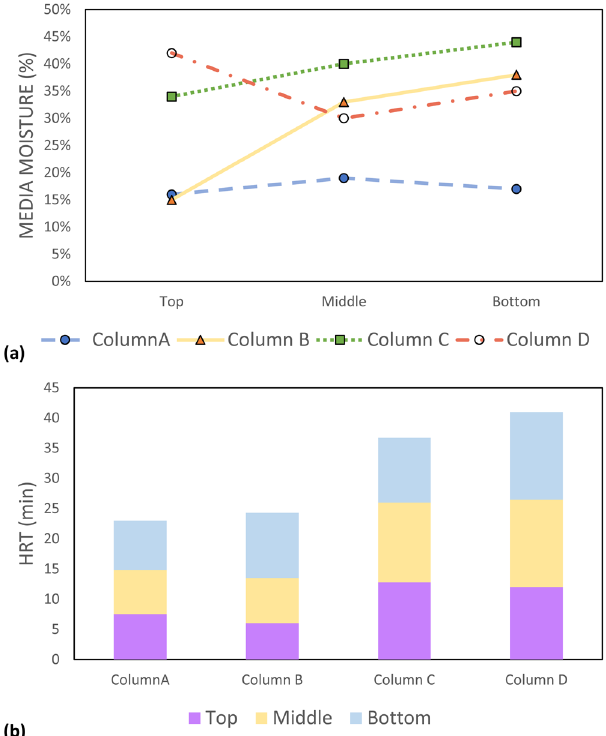
Figure 4. Outcome of the column study: ( a ) soil/media moisture content and ( b ) hydraulic retention time from each column section under operating